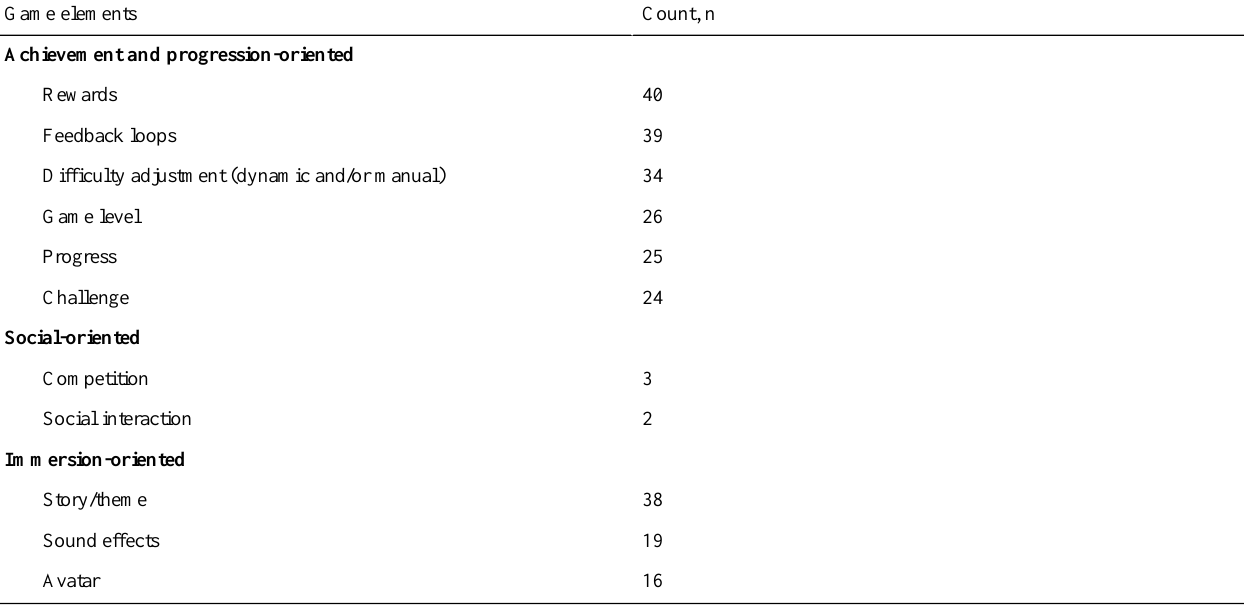
Table 1. Type of game elements used in the selected studies.